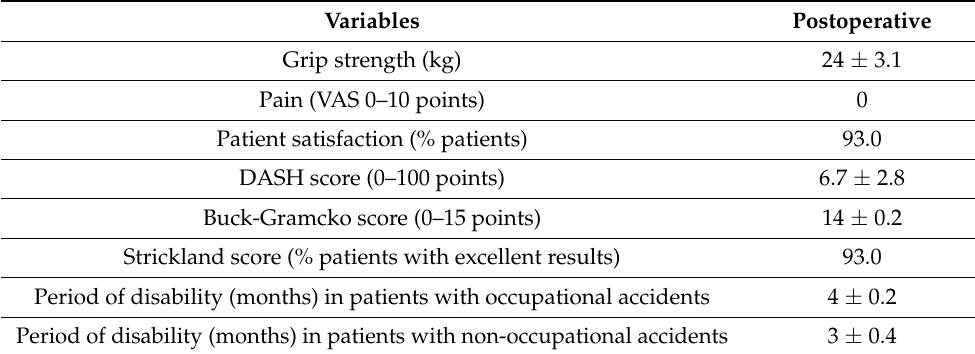
Table 2. The results of 29 patients (20%) in the 2nd phase of the study who were followed-up at least one year after flexor tendon repair with the Arthrex FiberLoop ® , Tsuge suture technique and early postoperative